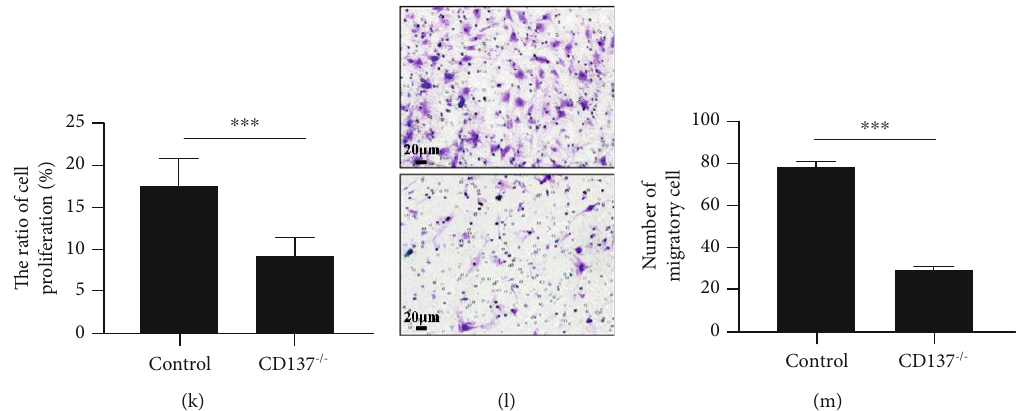
Figure 1: Knocking out/down endothelial CD137 impaired intraplaque angiogenesis. (a) The CD31 expression in ApoE -/- CD137 -/- mice and ApoE -/- mice detected by immunohistochemistry in aortic para ffi n sections is shown in brown color (black arrows indicate positive cells). (b) CD137 knock-out decreased CD31-positive areas signi fi cantly compared with the control. (c) Aortic rings sprouting in CD137 -/- and C57BL/6 J mice ( n = 5 for each group). (d) CD137 knock-out decreased the sprout number compared with the control aortic ring. (e) The silencing e ffi ciency of CD137 siRNA-1, -2, and -3 (100nM) detected by western blot. (f) siCD137-1 obviously silenced the expression of the CD137 protein. (g) Endothelial cell tube formation in siCD137 and control HUVECs. (h, i) The number of branch points and total length of tubes were both markedly decreased in CD137-silenced human umbilical vein endothelial cells (HUVECs). (j, l) The EdU-555 proliferation assay and transwell assay were applied to detect the proliferative and migratory ECs. (j) Red and blue fl uorescence represents proliferating cells and nuclei, respectively. (l) The violet color represents migrating cells stained with 0.1% crystal violet. (k, m) The numbers of proliferative and migratory ECs extremely decreased in CD137-silenced ECs. After siRNA transfection, ECs were treated with TNF α for 24h then applied to western blot, proliferation, and migration assay. ∗∗∗ p < 0 : 001 , (a), (g), and (l) scalebar = 20 μ m ; (c), (j) scale bar = 50 μ m , n = 3